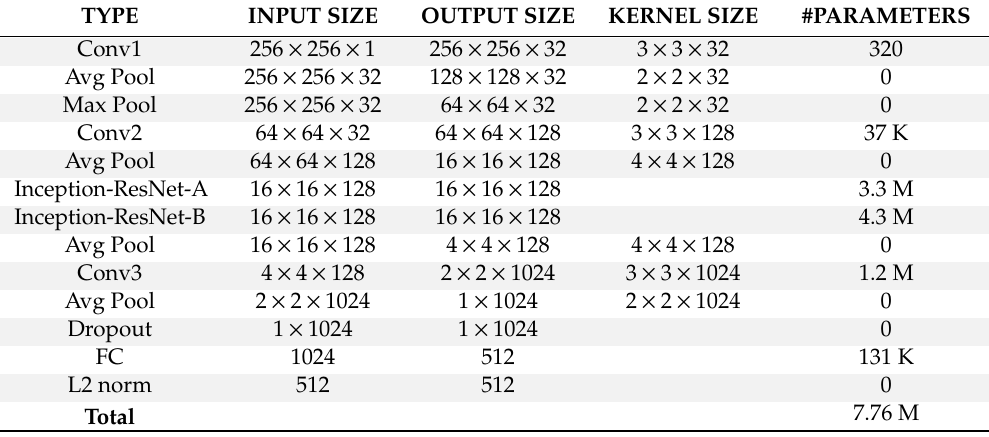
Table 2. Layer information of the FN13 model designed based on the hardware limitations with the use of L 2 -normalization